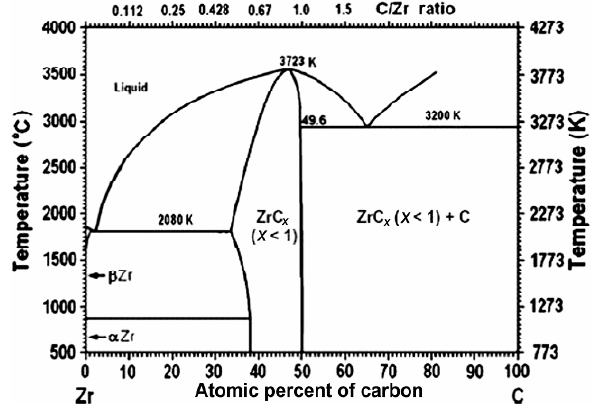
Fig. 4 Phase diagram of Zr–C system (reproduced with permission from Ref. [23], © 2013 Elsevier